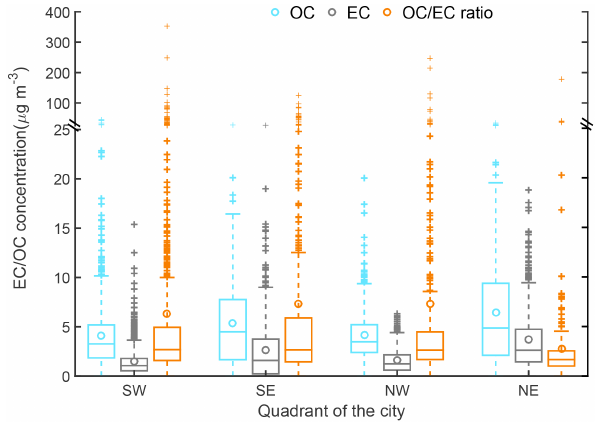
Figure 3. Spatial variation of OC and EC concentrations (µgm − 3 ) and OC / EC ratios in each quadrant of Riyadh. SW represents southwest Riyadh and includes the sampling cells 1, 2, 5, and 6; SE represents southeast Riyadh and includes the cells 3, 4, 7, and 8; NW represents northwest Riyadh and includes the cells 9, 10, 13, and 14; NE represents northeast Riyadh and includes cells 11, 12, 15, and